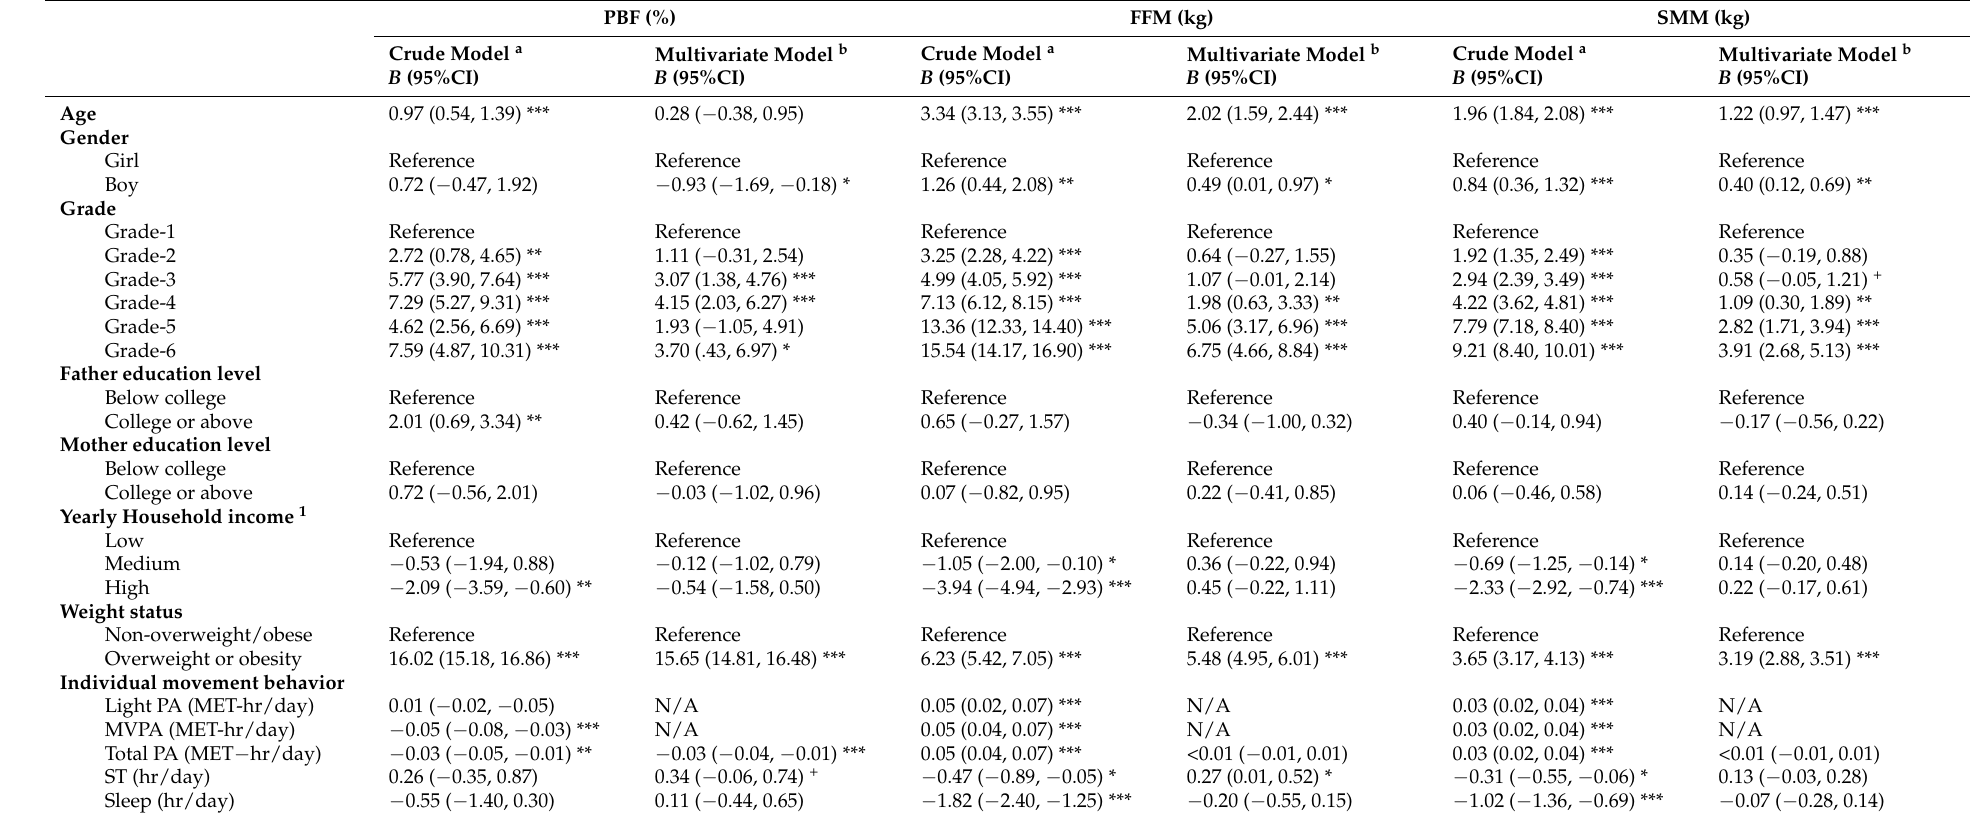
Table 3. Associations of individual movement behavior with body composition among the study sample ( n =